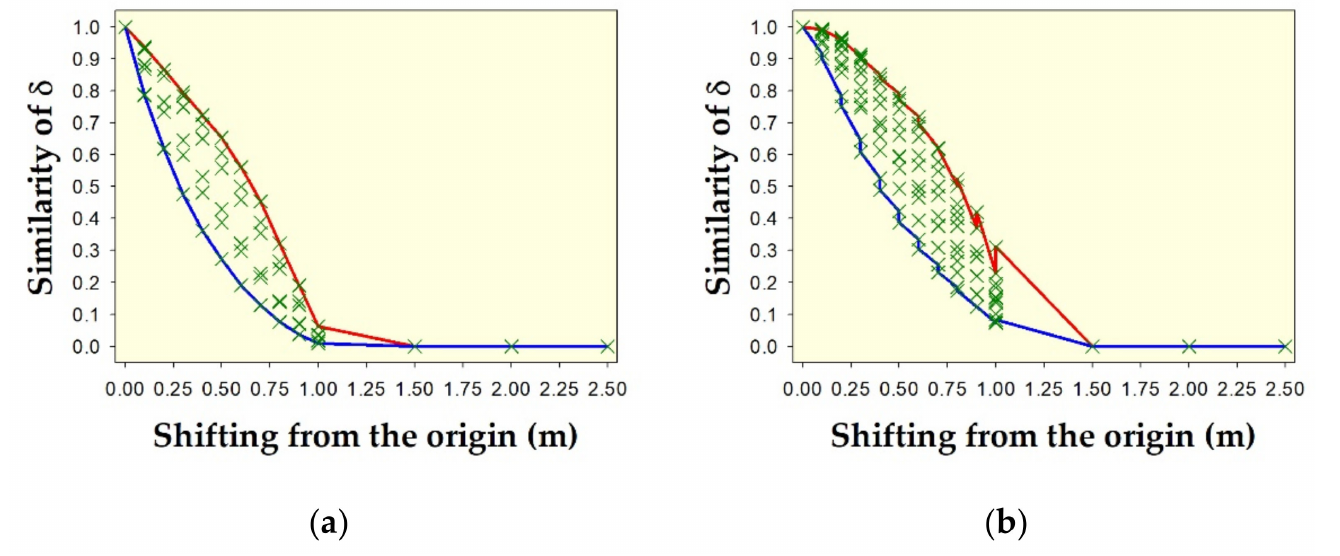
Figure 12. PDF similarity of distance from the centroid of origin to each point ( δ ) of two hypothetical shapes: ( a ) circle with diameter of about 1.0567 m, and ( b ) square with dimensions of 1.0567 × 1.0567 m 2 , due to shifting from the origin in all directions. Green crosses indicate the similarity of θ from all nine metrics. Red lines on the upper edge of the envelopes indicate the similarity of δ using the Fidelity metric. Blue lines on the lower edge of the envelopes indicate the similarity of δ using the metric of